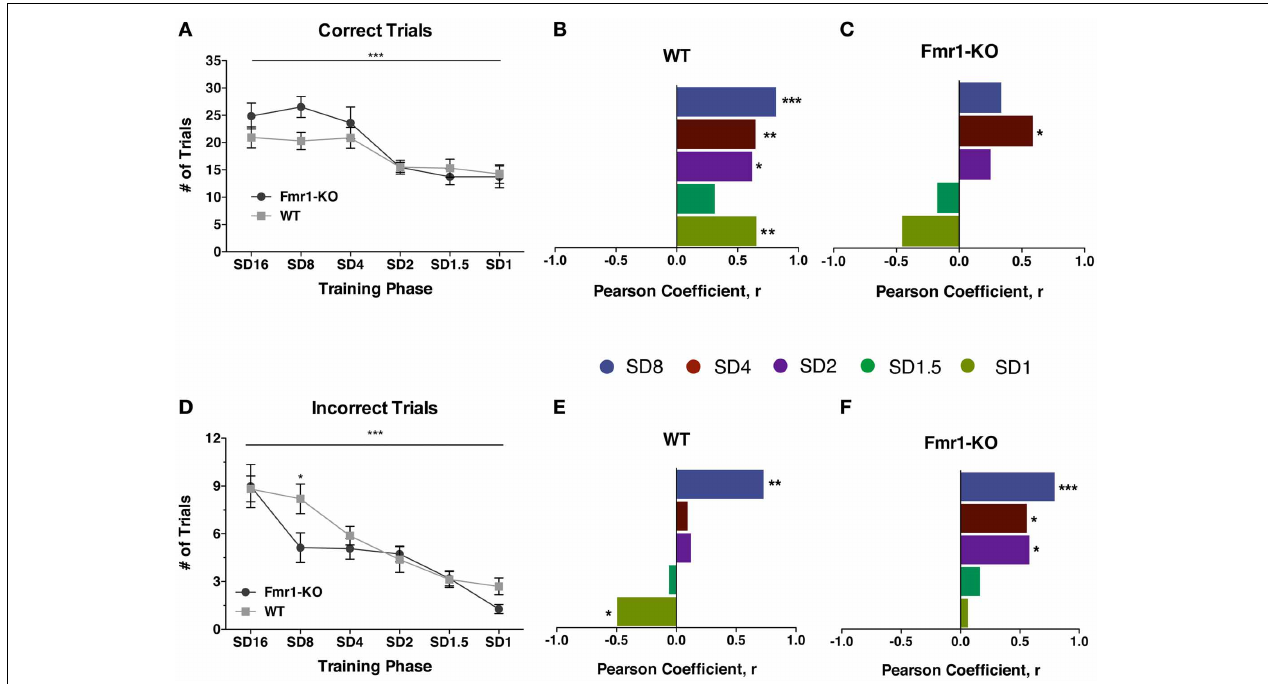
FIGURE 4 | Individual Fmr1 -KO mice fail to sustain correct response performance and are delayed in inhibiting incorrect responses. Correct trials are reduced for both Fmr1 -KO and WT mice with progressively shorter stimulus duration during the 5CSRTT training and SD1 testing phase (A) . Individual WT mice exhibited a consistent correlation in correct performance between SD16 and subsequent stages (B) . Fmr1 -KO individual mice failed to maintain a consistent correlation in correct performance (C) . Incorrect responses are significantly reduced for